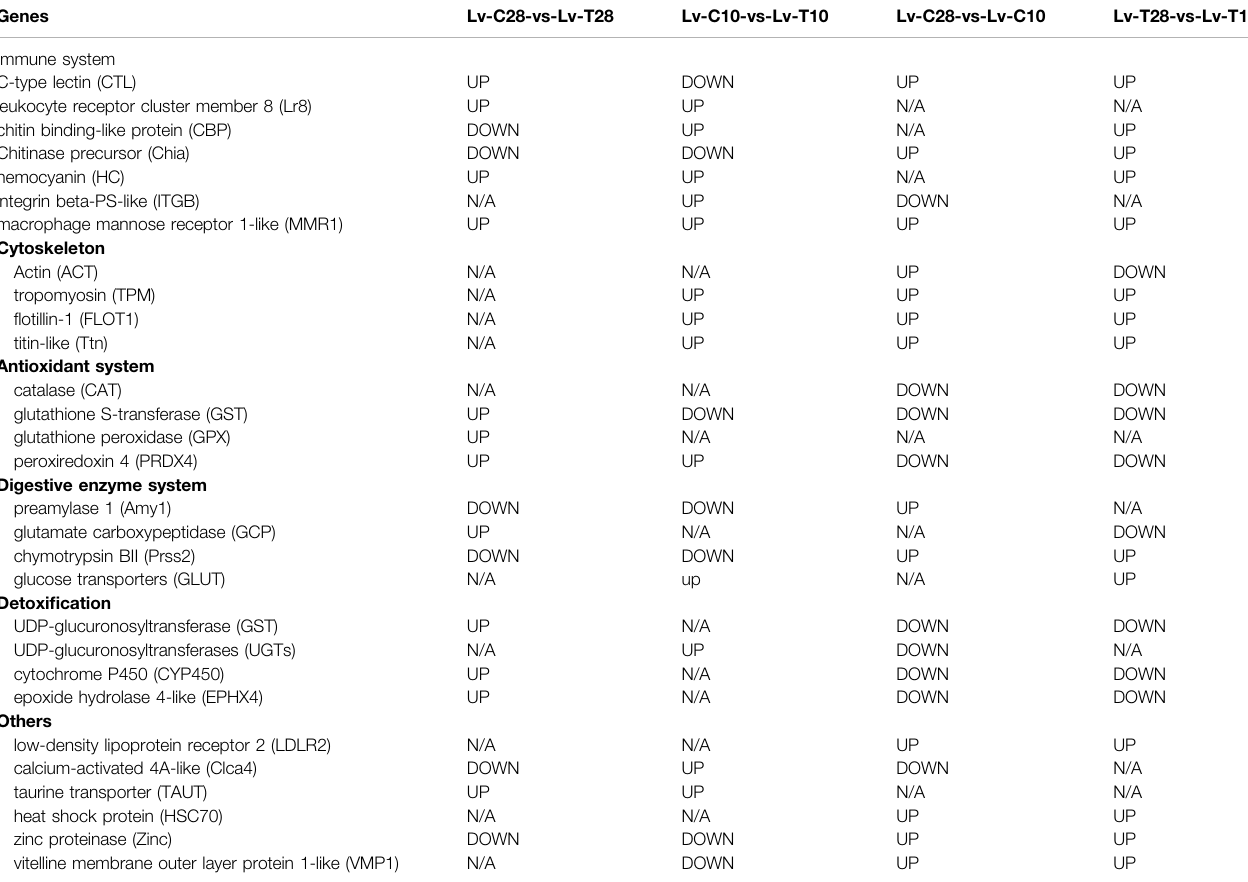
TABLE 1 | Genes differentially expressed in the hepatopancreas of Litopenaeus vannamei in response to cold stress. (N/A, not signi fi cantly differentially expressed).